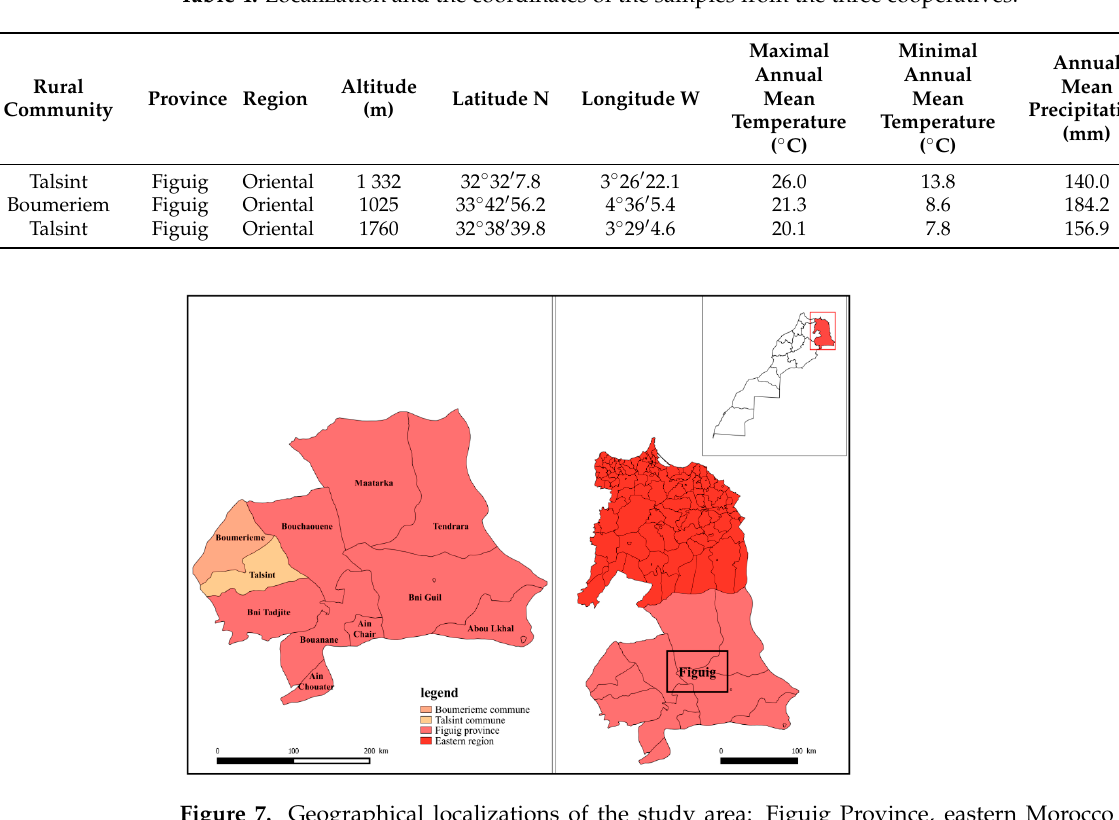
Figure 7. Geographical localizations of the study area: Figuig Province, eastern Morocco [68]. Made with QGIS software.